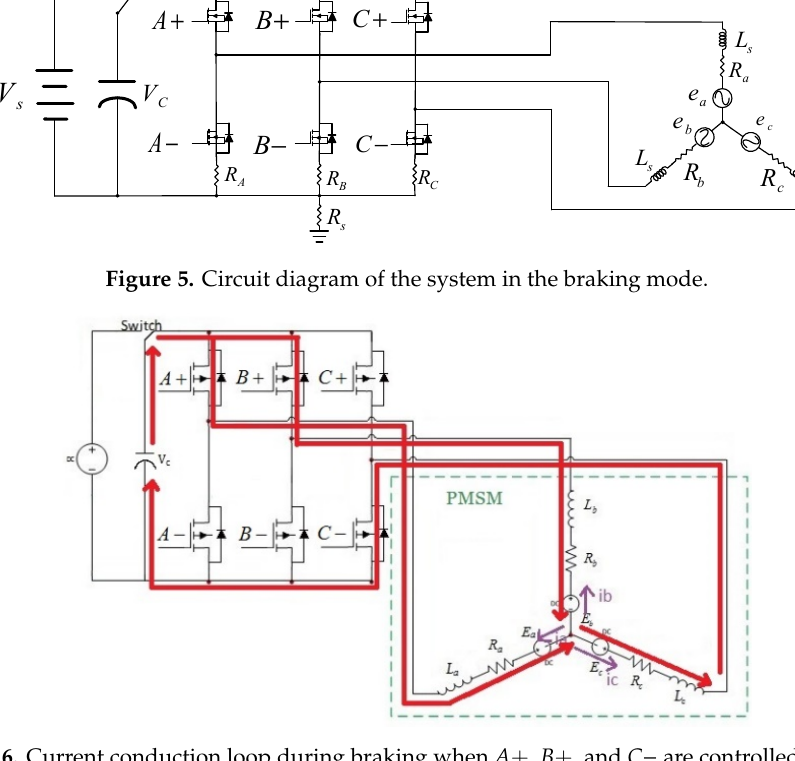
Figure 6. Current conduction loop during braking when A + , B + , and C − are controlled at ‘ON’. Table 2. Control logic of six basic voltage vectors defined by SVM for driving and braking modes. Control Logic of Voltage Vector Voltage Vector